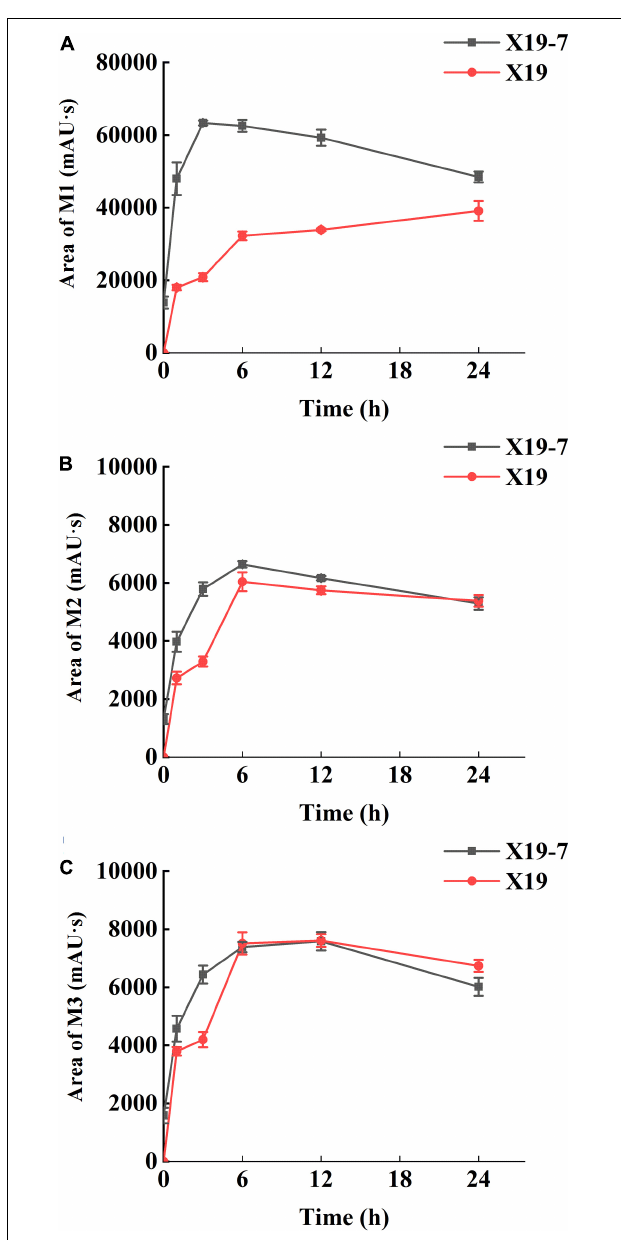
FIGURE 2 | Quantification of SYP-14288 metabolites M1 (A) , M2 (B) , and M3 (C) in the mycelia of Rhizoctonia solani X19 and SYP-14288-resistant mutant X19-7. SYP-14288 was quantified at 0, 1, 3, 6, 12, and 24 h after treatment in ultra-performance liquid chromatography-tandem mass spectrometry. Values are mean ±